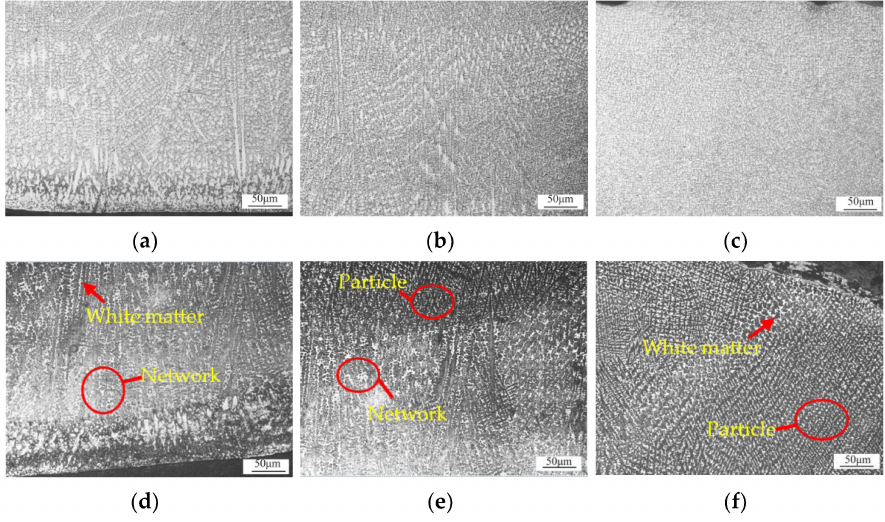
Figure 19. OM observation of Cladding layer 5# after aging treatment: ( a – c ) bottom, middle and top of coating after aging for 2 h; ( d – f ) bottom, middle and top of coating after aging for 16